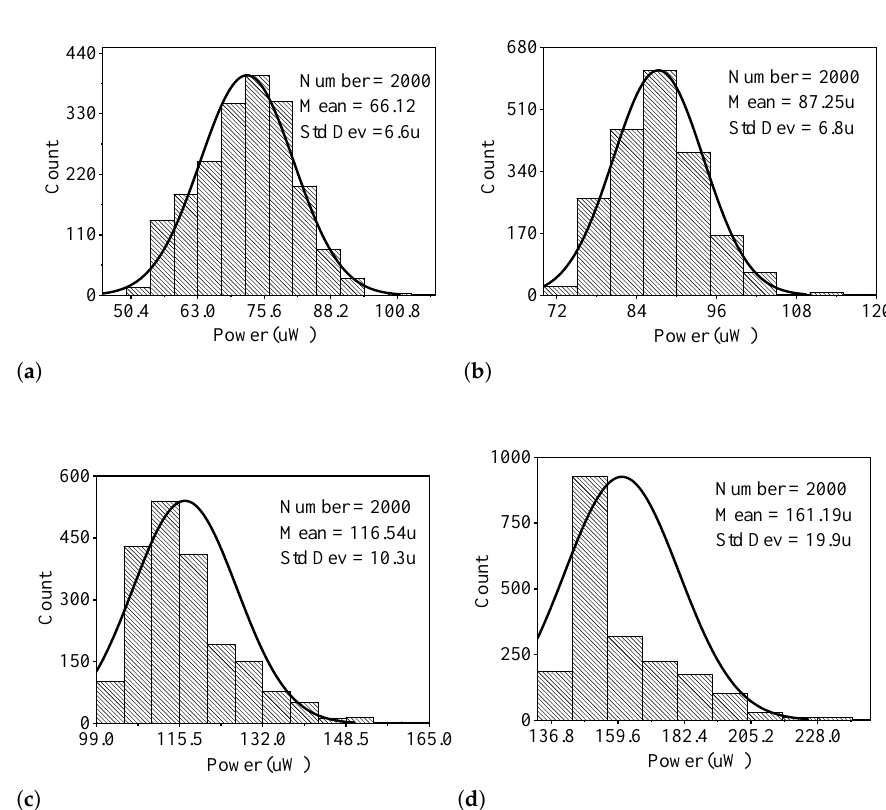
Figure 13. The results of Monte Carlo analysis for total power of proposed two-row multiplier. Table 6. Comparison of conventional booth multipliers [44,45]. NVM-based multipliers [3,46] and the proposed multiplier. Process